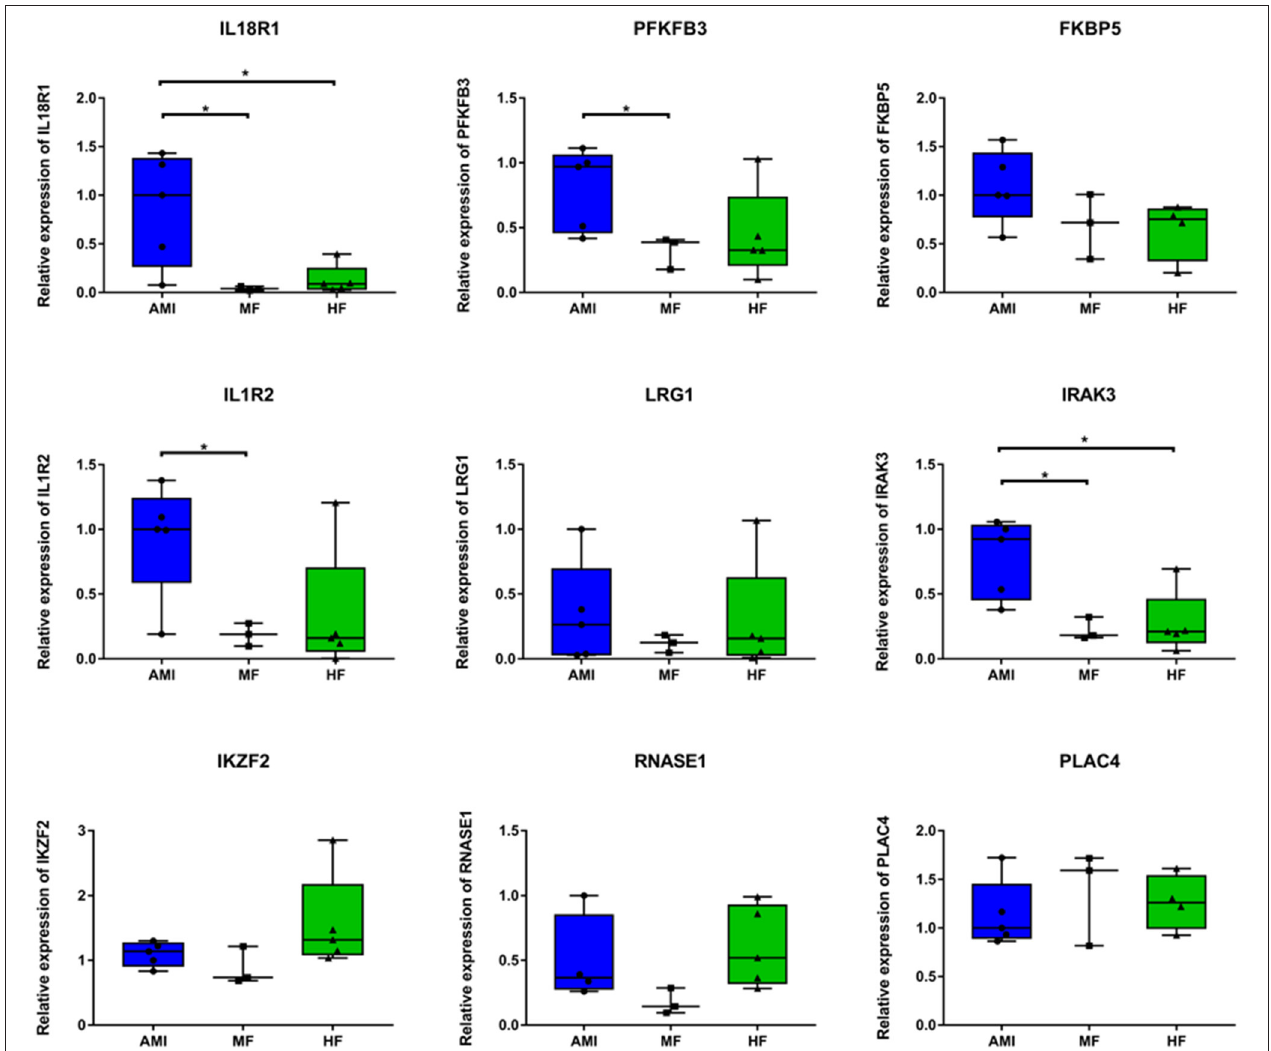
FIGURE 5 | The in vitro qPCR validation of key differentially expressed lncRNAs and mRNAs. * p < 0.05.